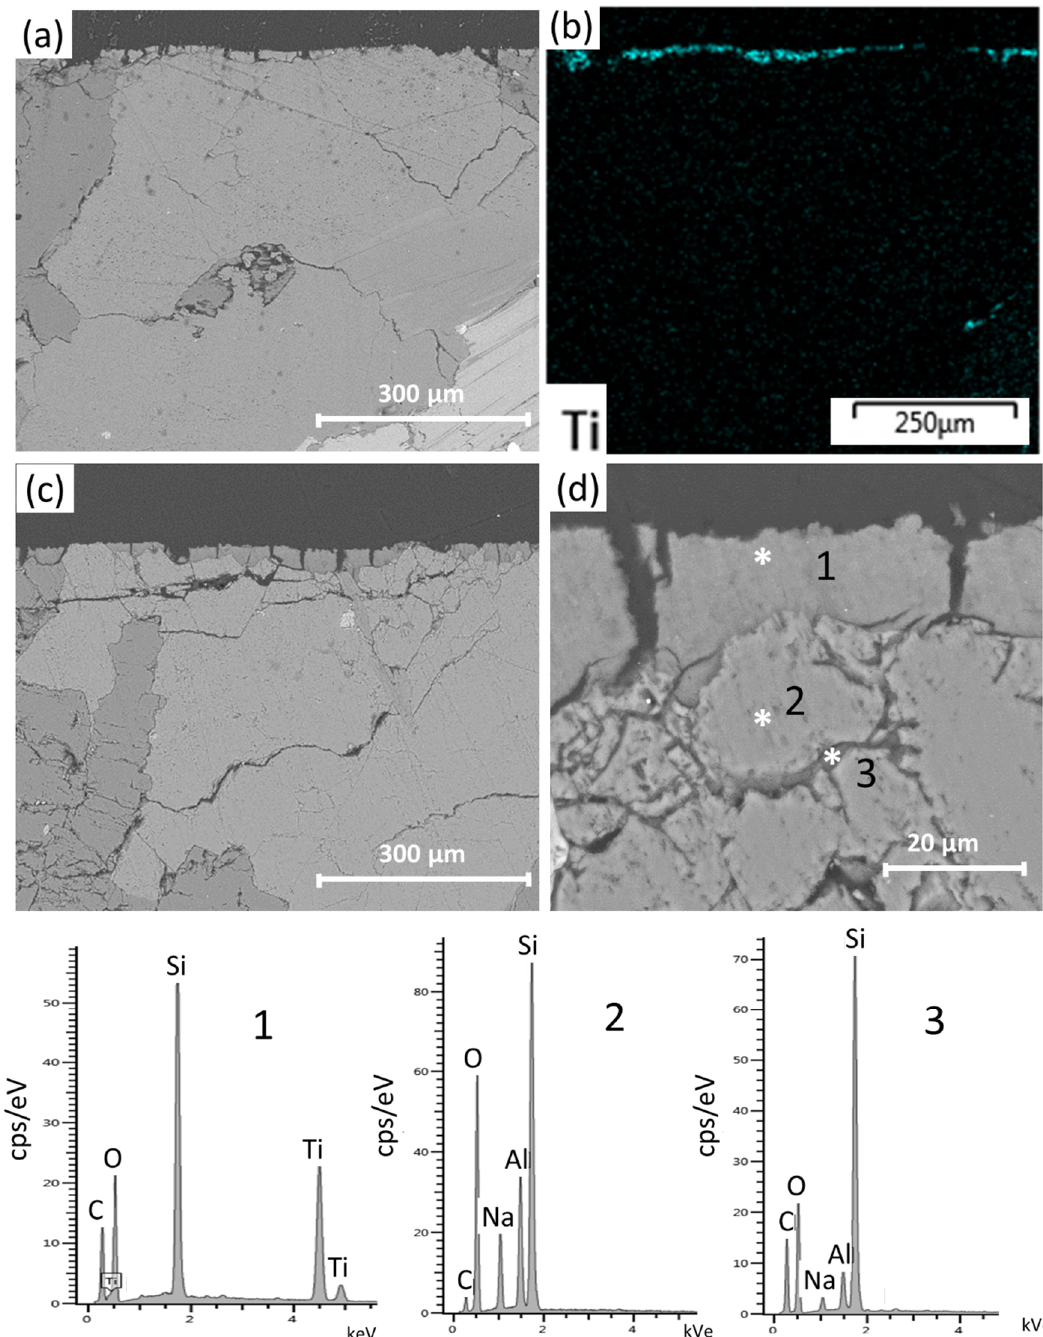
Figure 9. SEM micrographs of the polished cross sections from the surfaces treated with consolidant doped with 3 wt % of TiO 2 nanoparticles. ( a ) Estel 1000 treated surface. ( b ) Ti compositional map. ( c , d ): Nano Estel-treated surface, (d) is accompanied with the EDS spectra.